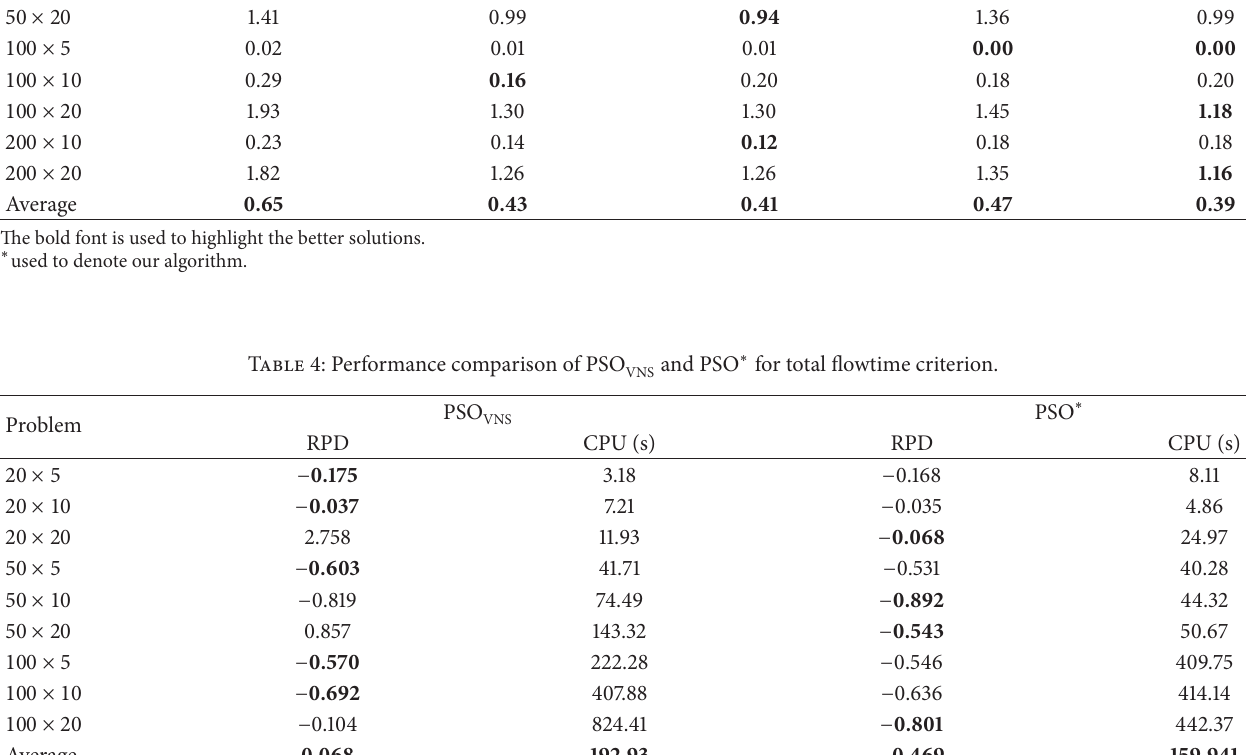
Table 3: ARPD comparison of different methods for makespan criterion.